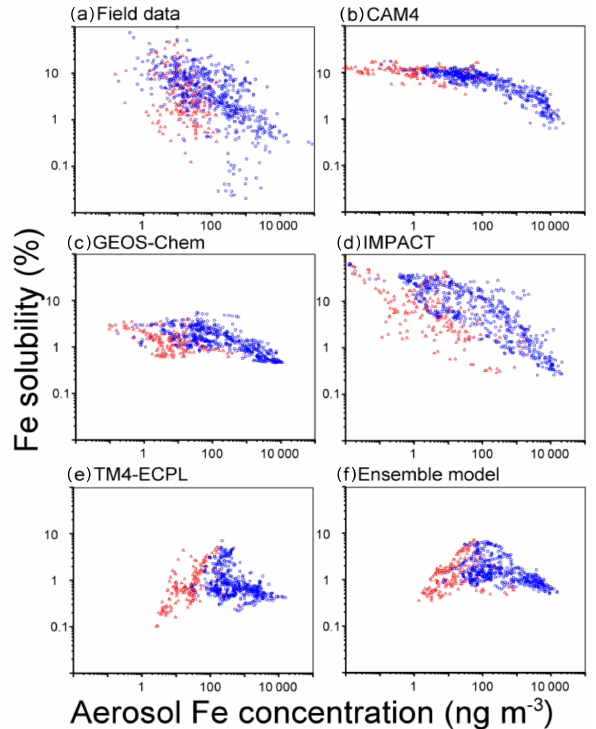
Figure 5. Fe solubility versus atmospheric concentrations of aerosol Fe (ngm − 3 ) in the Northern Hemisphere (blue circles) and South- ern Hemisphere (red squares) for (a) the measurements, (b) CAM4, (c) GEOS-Chem, (d) IMPACT, (e) TM4-ECPL and (f) the ensem- ble model. The bias correction in the mineral dust size distribution is applied for the comparison with field data (Kok et al.,